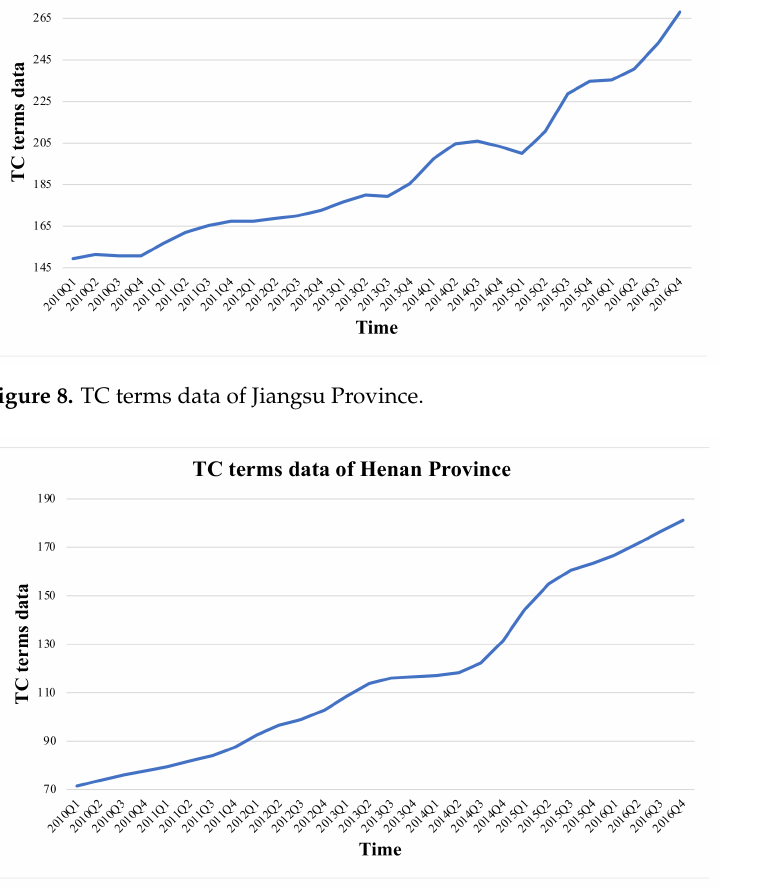
Figure 9. TC terms data of Henan Province. Table 7. Complexity trait test results for